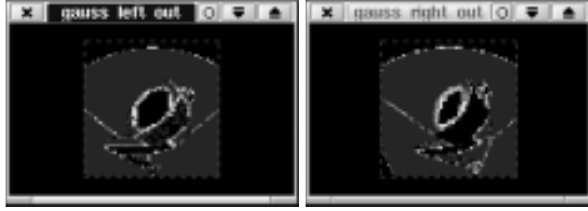
Figure 7 TE (tuned excitatory) filter input images.